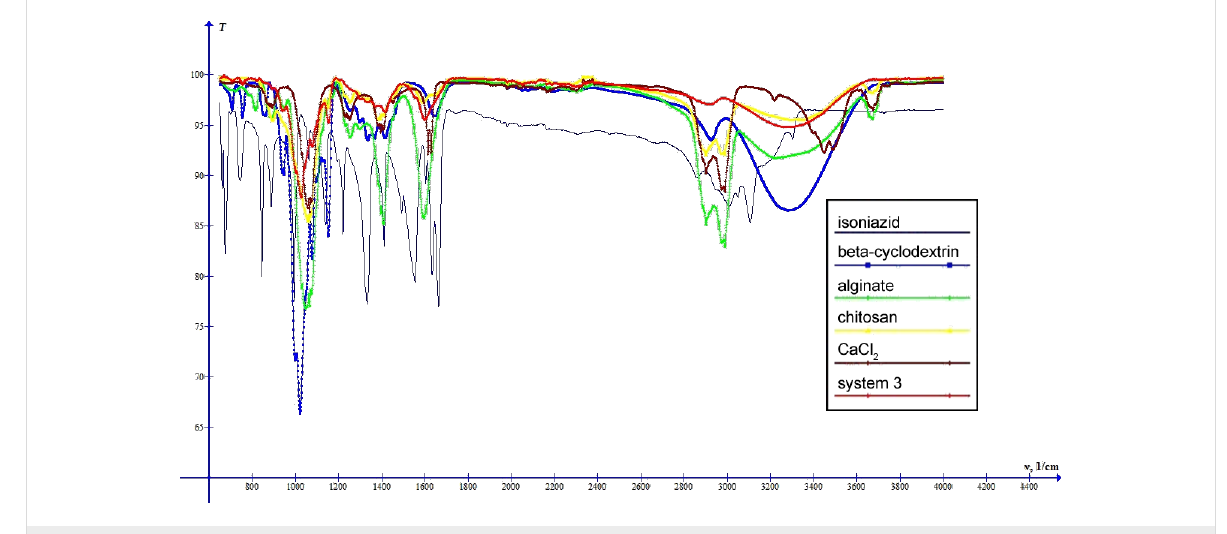
Figure 9: IR spectra of INH, β -cyclodextrin, sodium alginate, chitosan, calcium chloride and system 3.